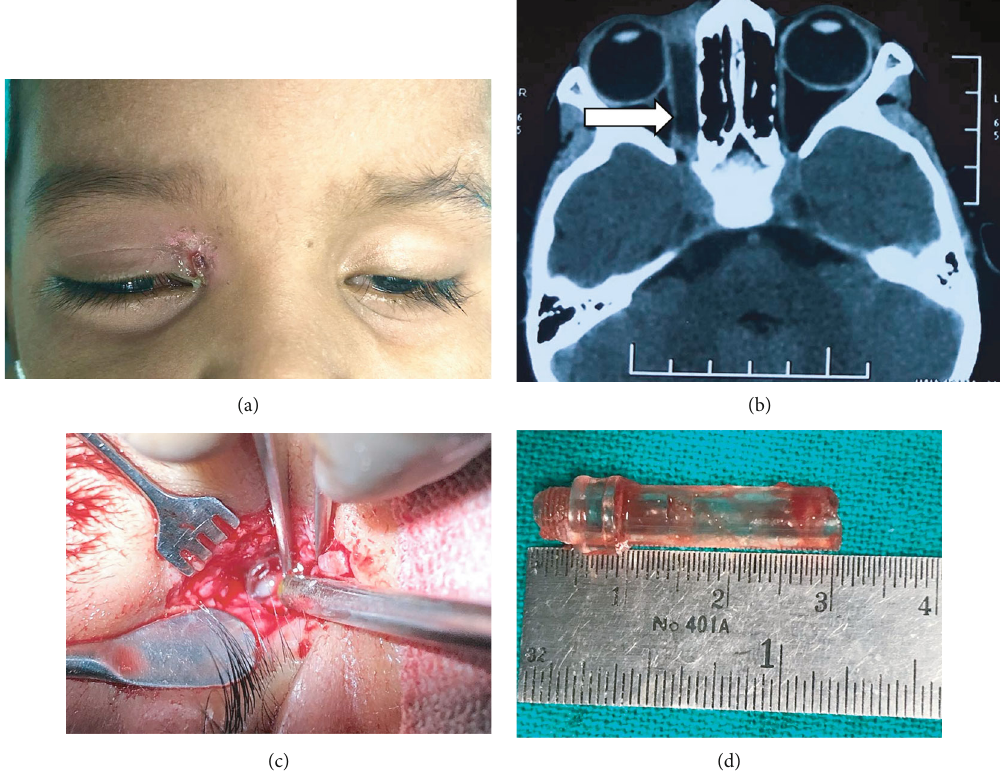
Figure 2: Illustrative case 1: (a) preoperative photograph revealing chronic discharging sinus in the right superomedial region; (b) NCCT orbit suggestive of a linear nonmetallic foreign body along the right medial wall of the orbit (arrow); (c) surgical exploration was performed; (d) retrieved plastic foreign